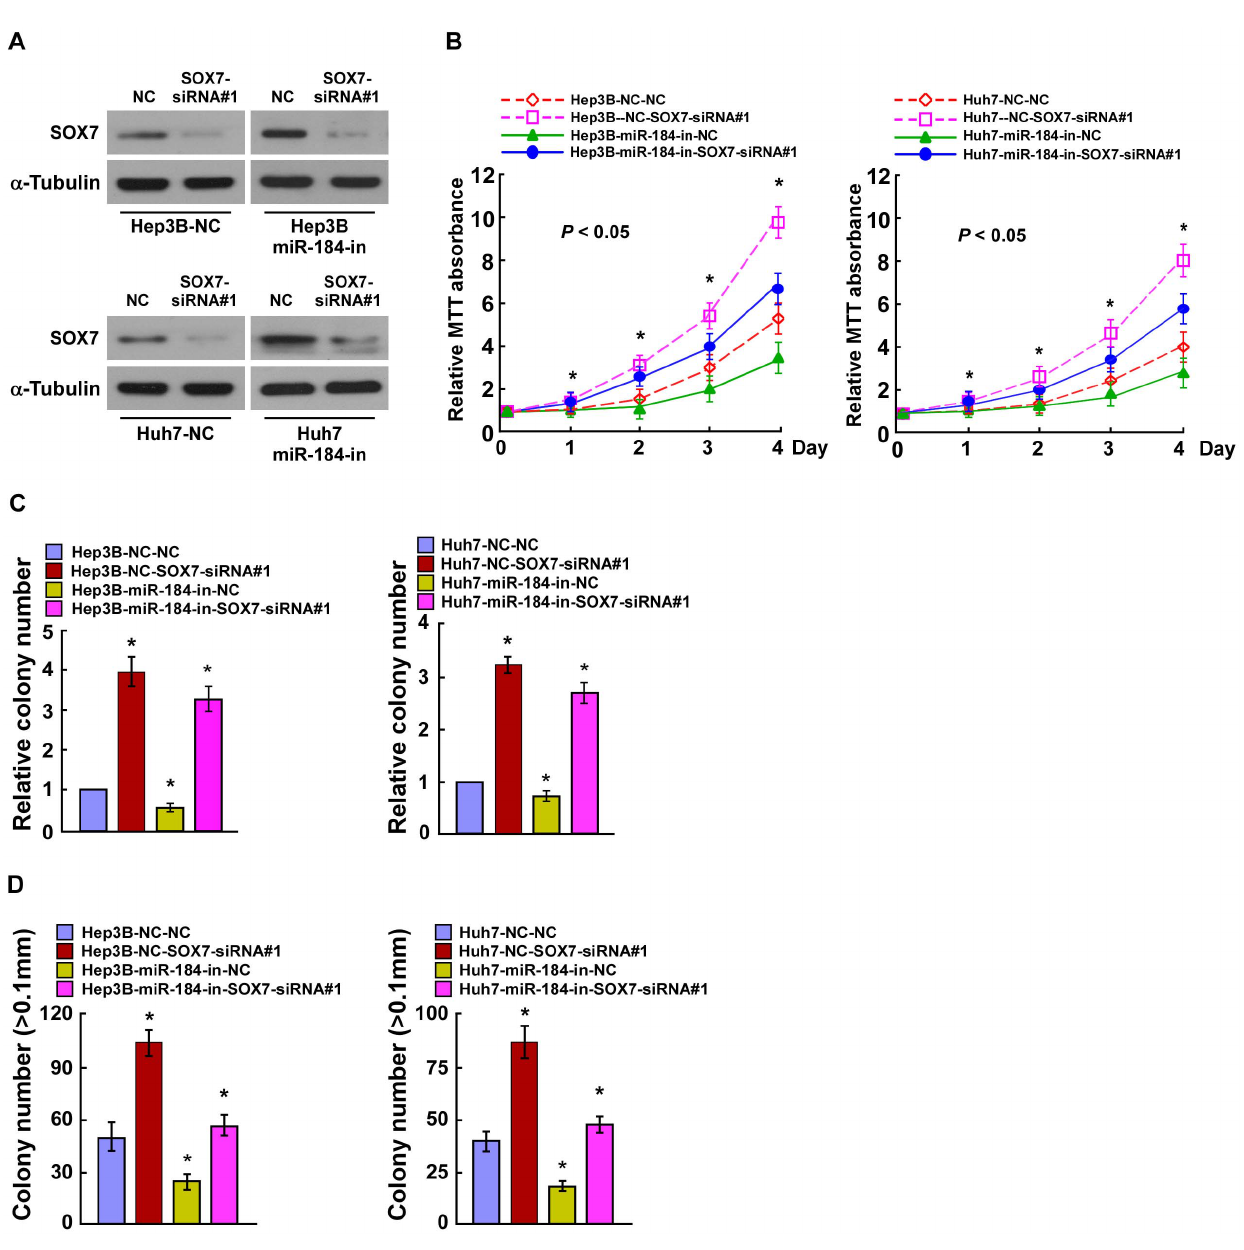
Figure 5. MiR-184 promotes HCC proliferation by inhibiting SOX7. A . The expression levels of SOX7 in miR-184-inhibitor transfected HCC cells that were transfected with SOX7-siRNA # 1, as measured by western blotting; a -Tubulin served as the loading control. B . The growth rates in SOX7-silenced cells, as indicated by the MTT assay. C . Quantifications of crystal violet stained cell colonies formed by indicated HCC cell lines, 10 days after inoculation. D . Quantifications of colony numbers of indicated cells determined by an anchorage-independent growth assay. Colonies larger than 0.1 mm in diameter were scored. Error bars represent the mean 6 SD from three independent experiments. * P , 0.05.